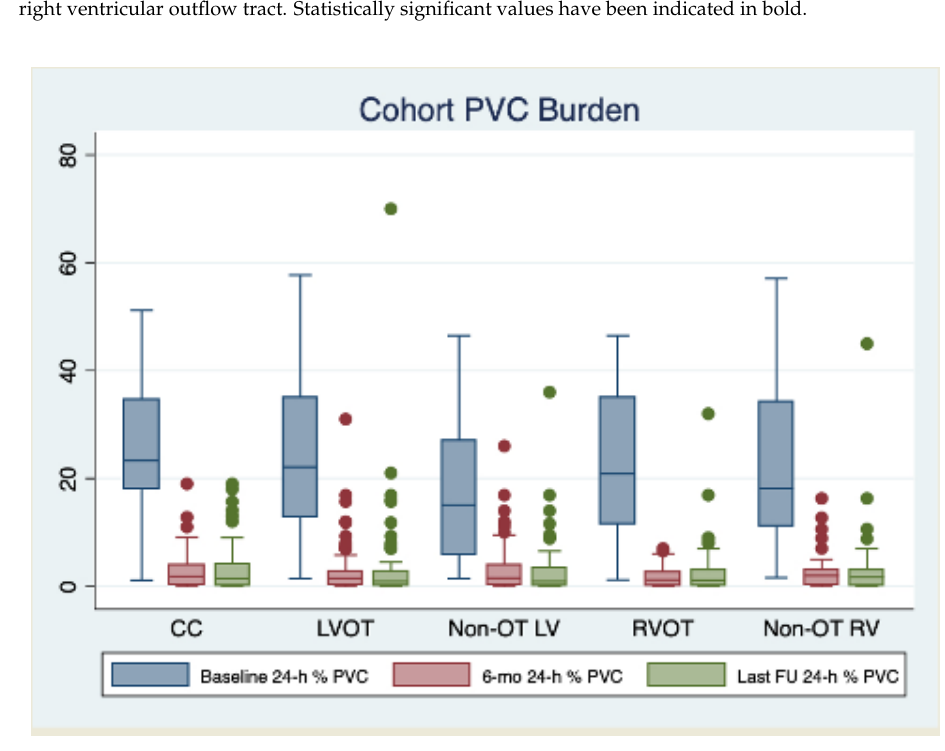
Figure 2. Clinical success of PVC catheter ablation stratified by arising zones, graphically displayed by Kaplan–Meier curves.